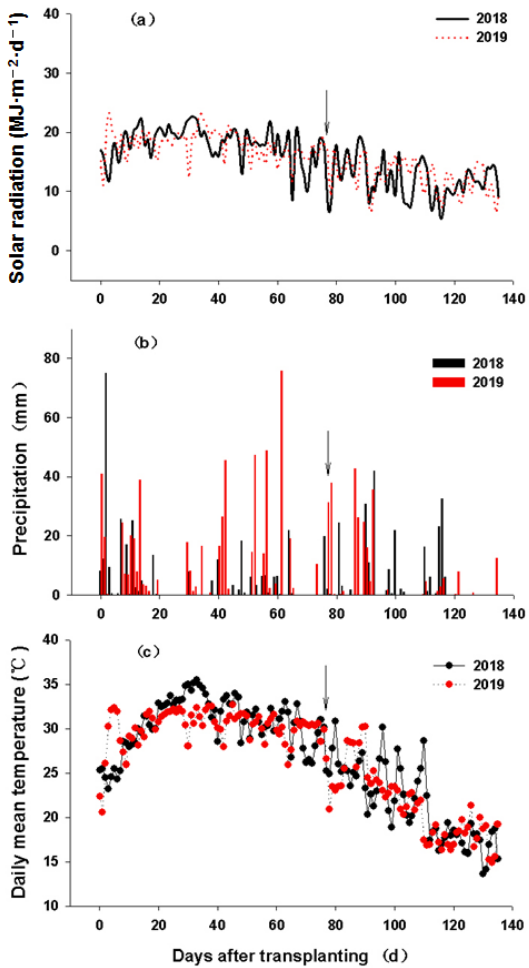
Figure 1. The solar radiation ( a ), precipitation ( b ), and daily mean temperature ( c ) during the rice growing season across the two testing years, 2018 and 2019. Arrows indicate the mean heading time.